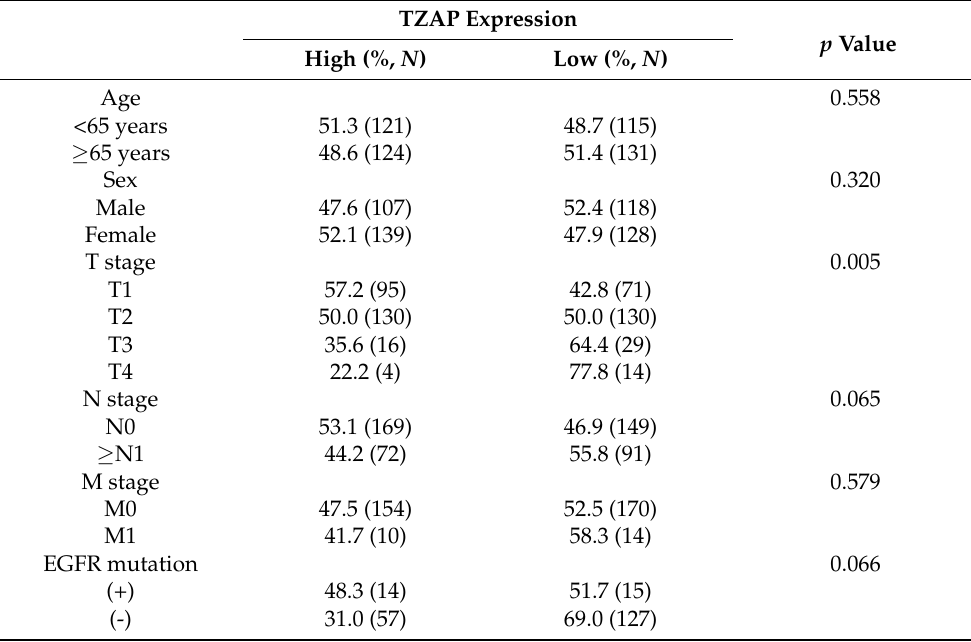
Table 1. Clinical characteristics of TZAP mRNA expression in lung adenocarcinoma.